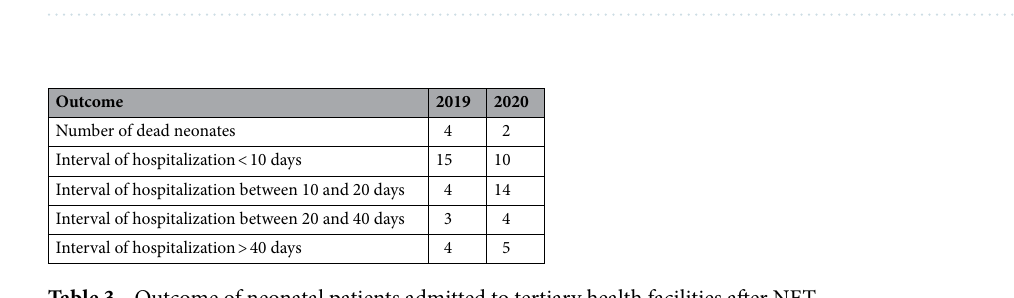
Table 2. The ISTAT data related to the infant mortality rate (per 1.000 live births) of the province of Catania, Enna, Caltanissetta and Agrigento available until 2018.